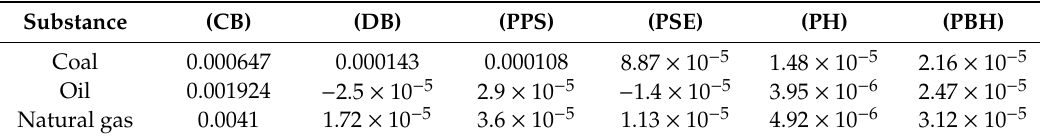
Table 11. Results of characterization of environmental impacts for the category of fossil fuel deficiency (USD2013).